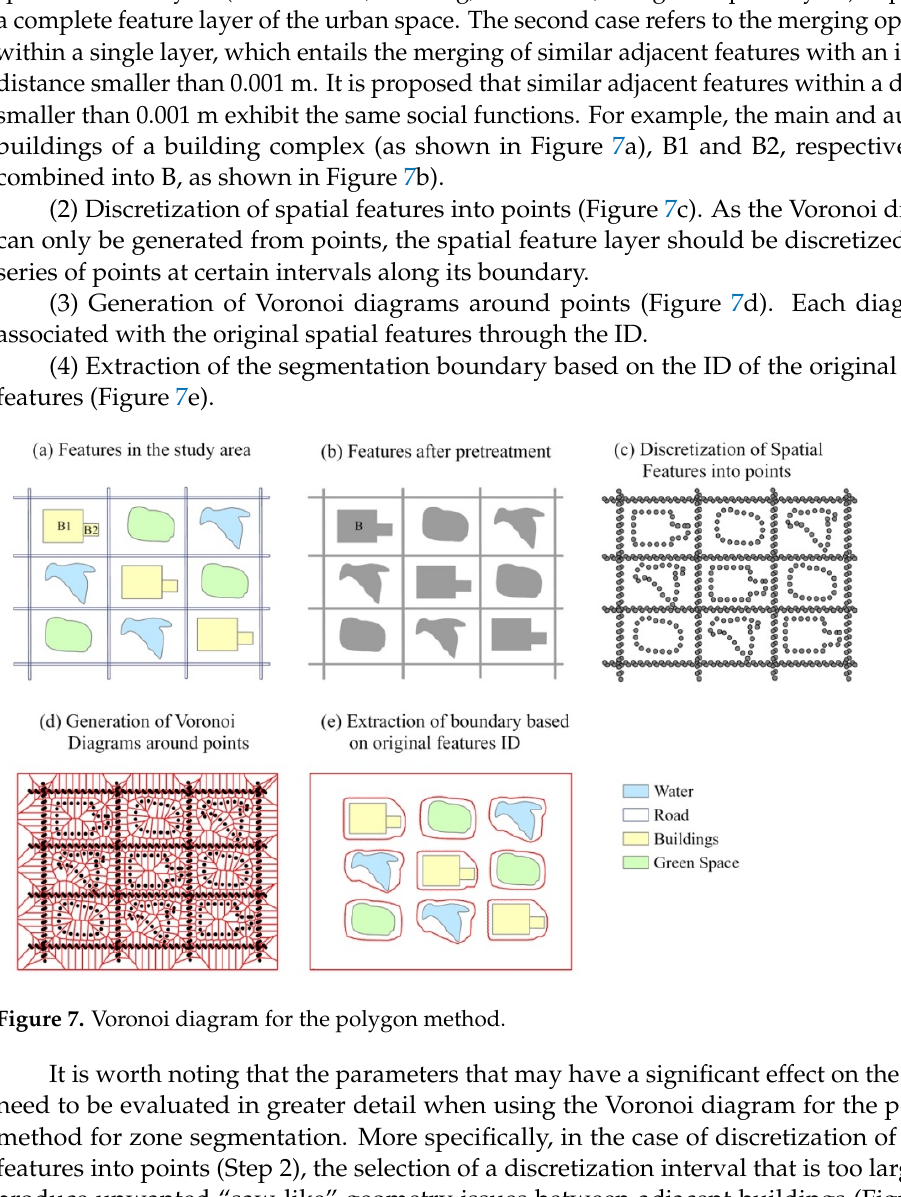
8 of 21 Figure 6. Thiessen polygons based on randomized points.